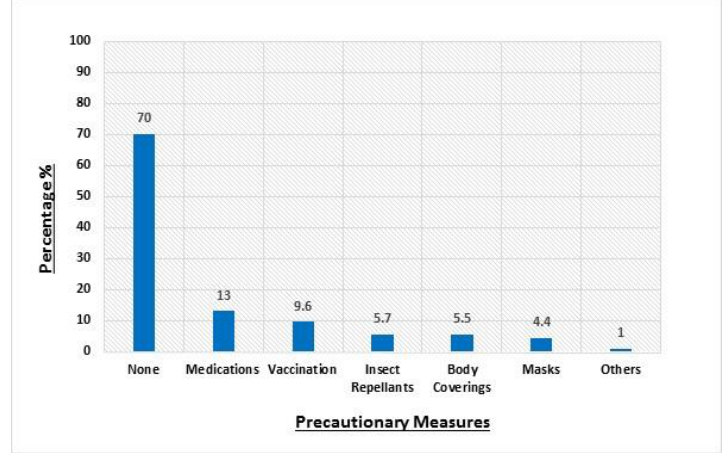
Figure 1. The proportion of different precautionary measures undertaken prior to travelling: The respondants were permitted to chose more than one option. The majority did not take on any precautionary measures